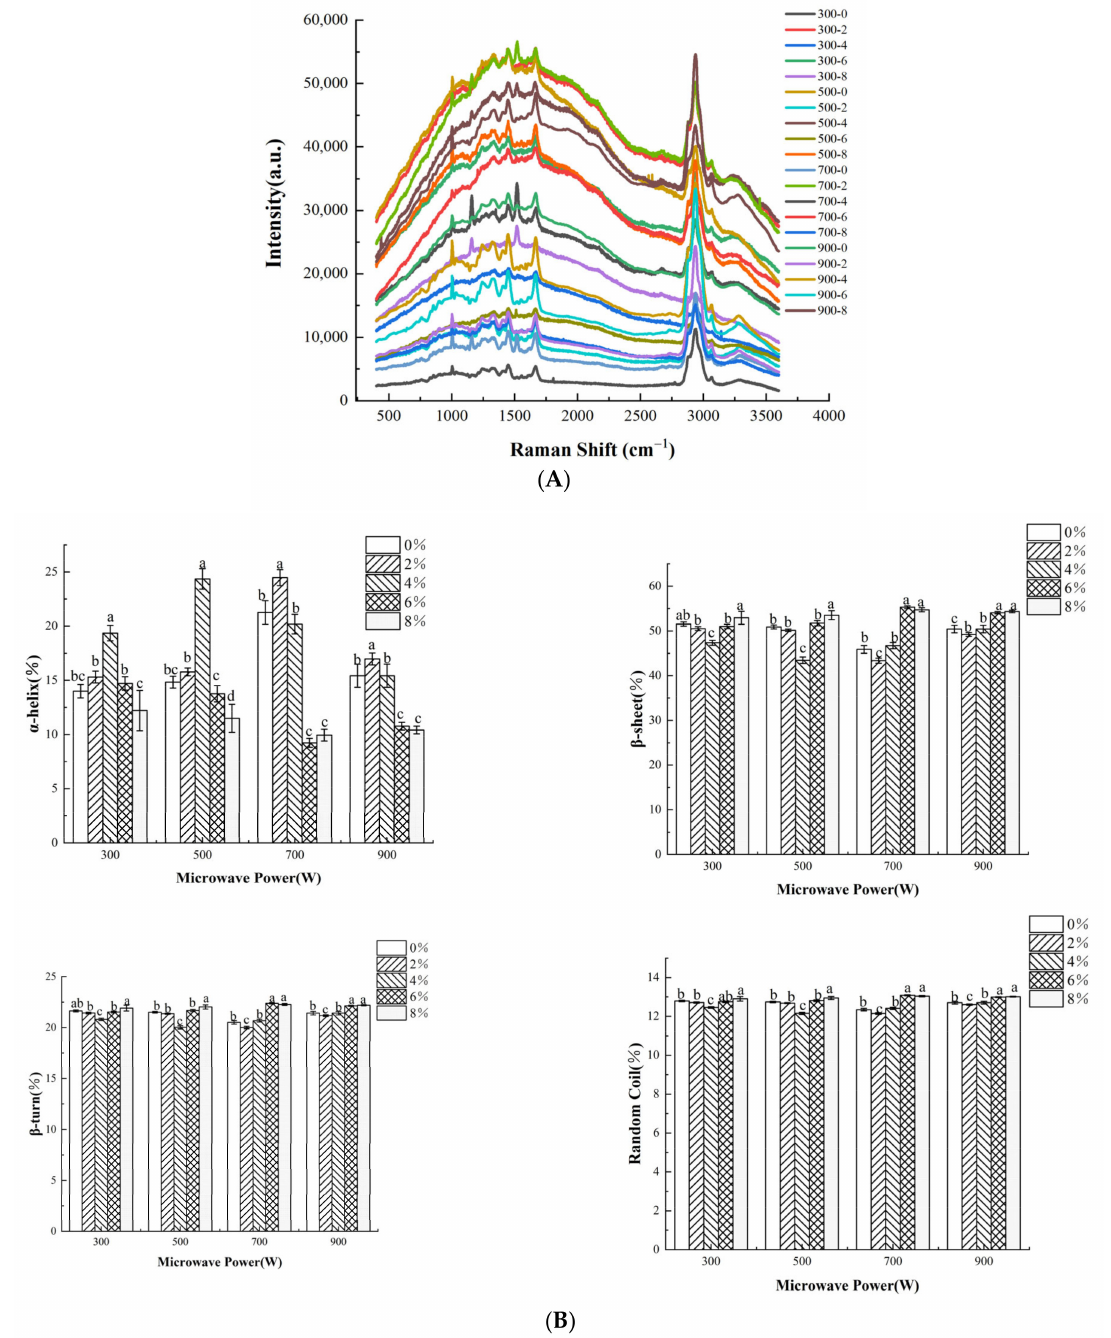
Figure 6. Raman spectra ( A ) and different proportions of secondary structures of proteins under different heating treatments of dried shrimps ( B ) (a.u.: arbitrary units). Different letter indicates statistically significant difference at p < 0.05 according to the Duncan